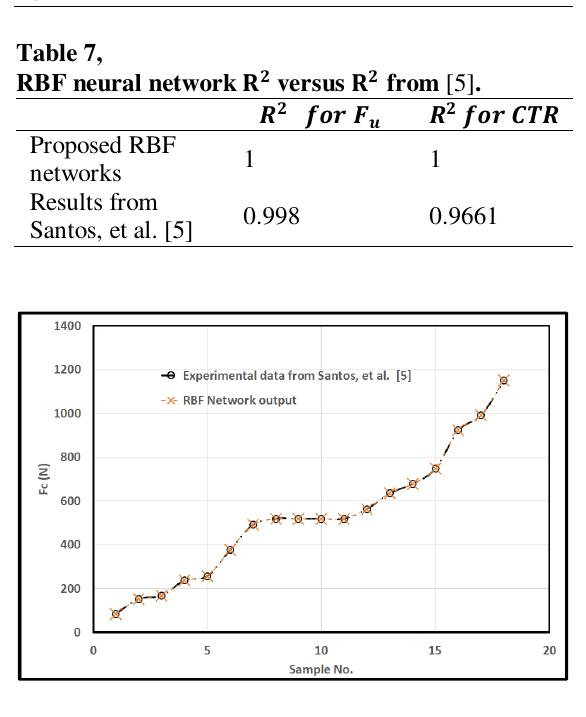
Fig. 4 The neural network for the experimental data from Santos, et al. [5]